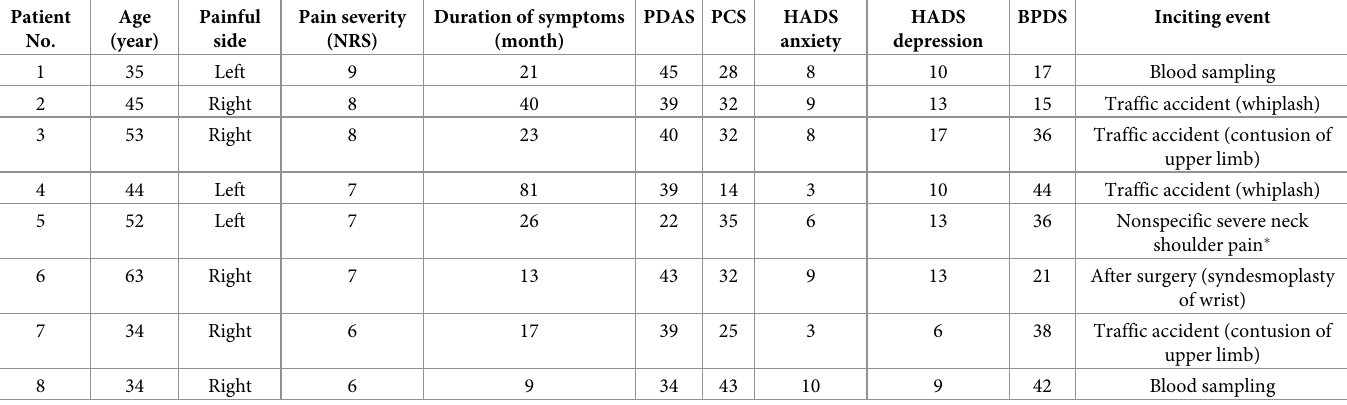
Table 1. Characteristics of CRPS patients.